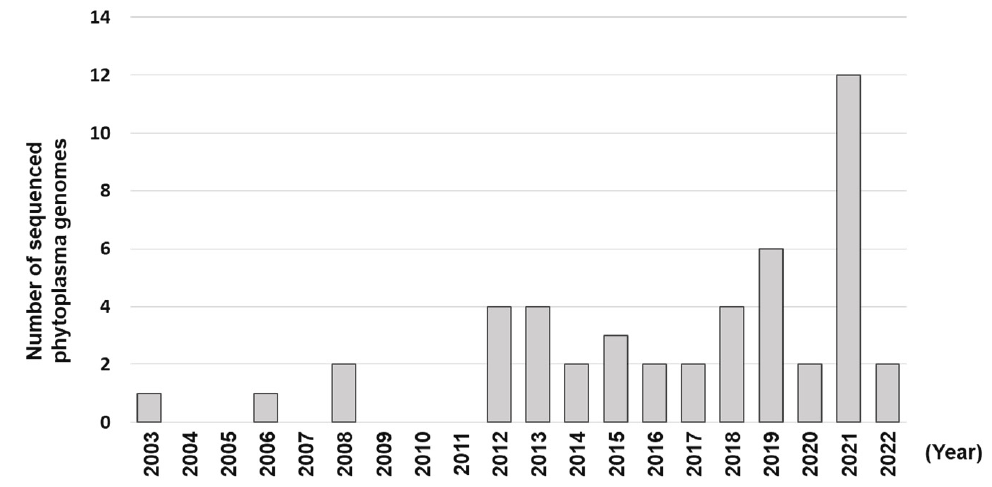
Figure 2. Number of phytoplasma genomes sequenced per year since 2003.